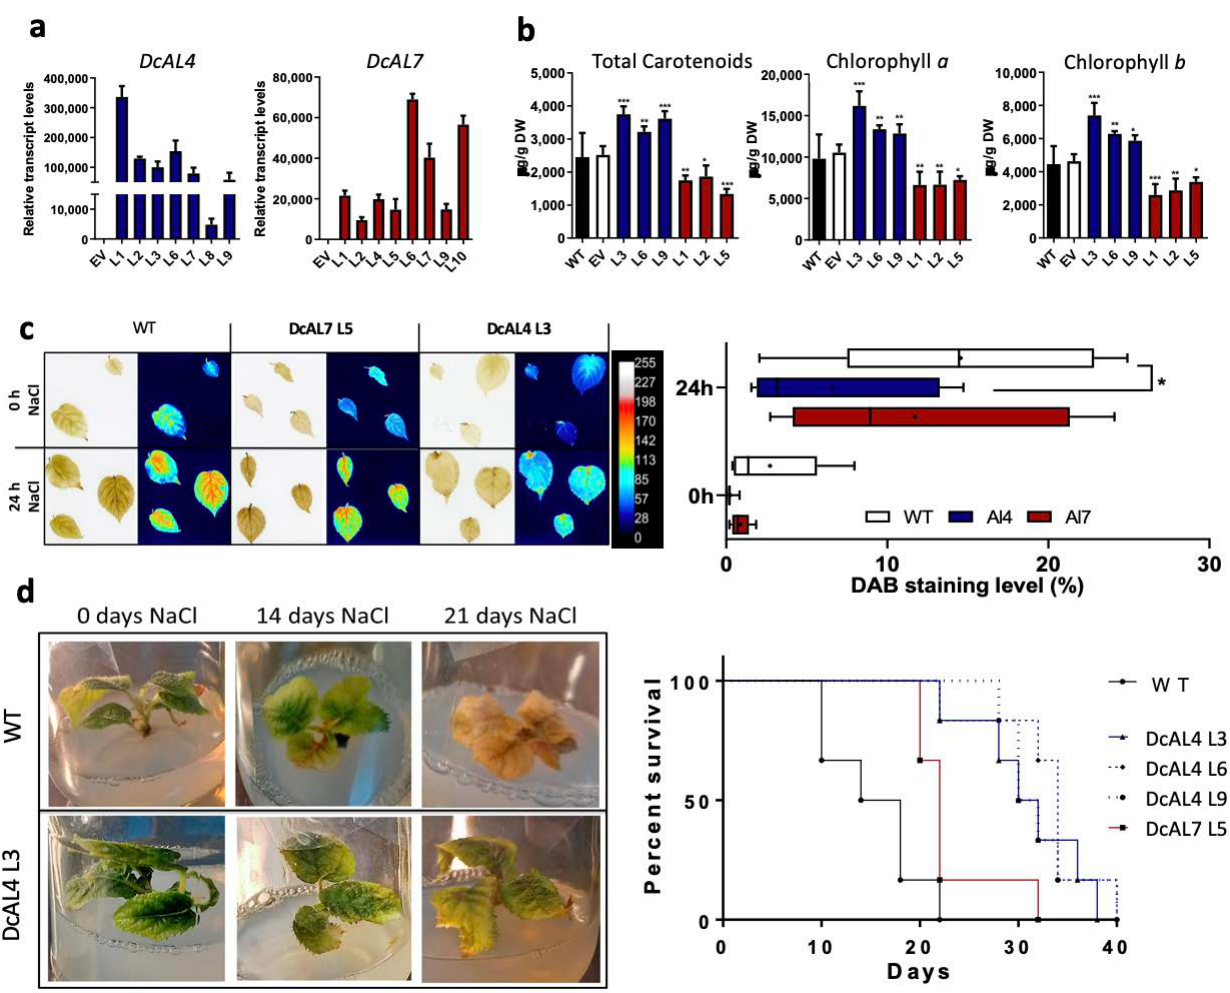
Figure 4. Effect of DcAL4 and DcAL7 ectopic expression in A. deliciosa. ( A ) DcAL4 and DcAL7 relative transcript levels in A. deliciosa Al4 and Al7 T0 lines, respectively. ( B ) Carotenoid and Chlorophylls content in leaves of selected Al4 and Al7 lines. ( C ) Hydrogen peroxide content in leaves of Al4 and Al7 A. deliciosa lines subjected to acute treatment with NaCl. Representative image of WT, Al4 and Al7 A. deliciosa leaves pre- and post-treatment with 250 mM NaCl stained with DAB, as well as